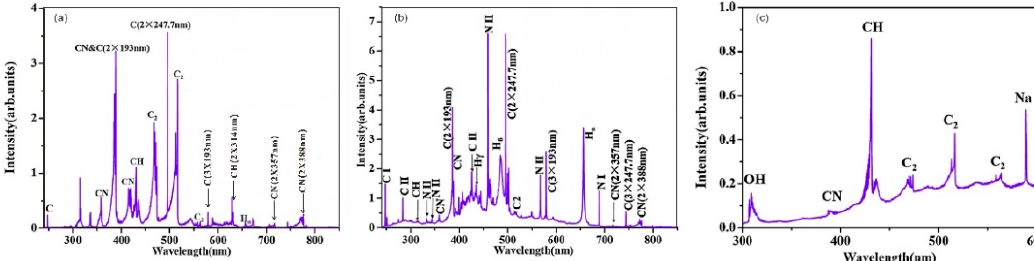
Figure 4. A comparison of emission spectra obtained by ( a ) femtosecond filament excitation, ( b